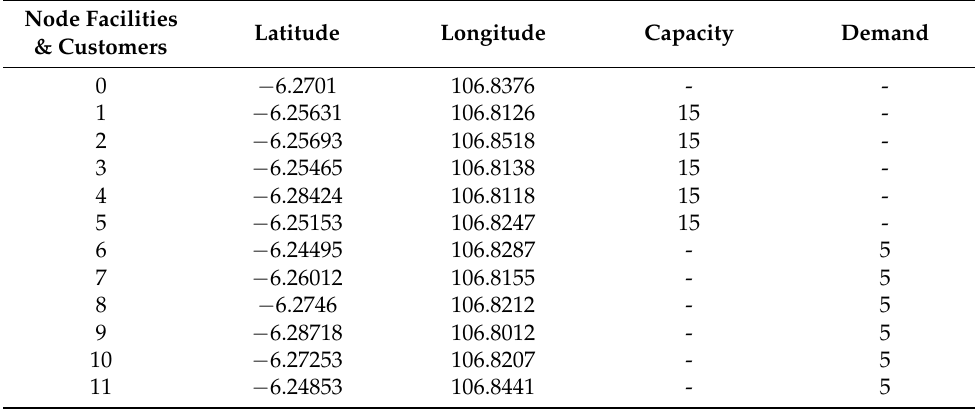
Table 1. Example of location, capacity, and demand for Table 2. Illustration of cost matrix between nodes in 2EVRP-DF.